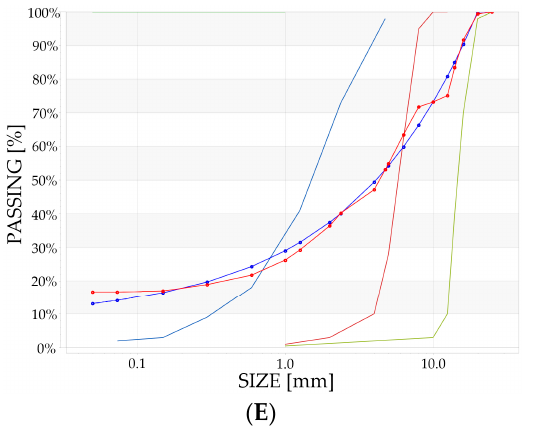
Figure 8. Gradings and fitting curves for designed concrete recipes: ( A ) 10 MPa; ( B ) 20 MPa; ( C ) 30 MPa; ( D ) 40 MPa; ( E ) 50 MPa; Legend in the left bottom corner.